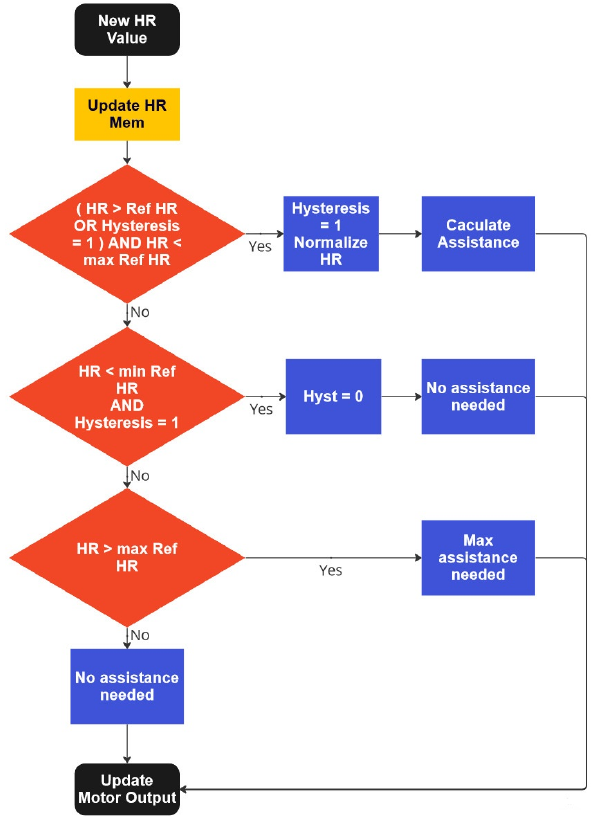
Figure 3. Flow diagram of the PD approach.